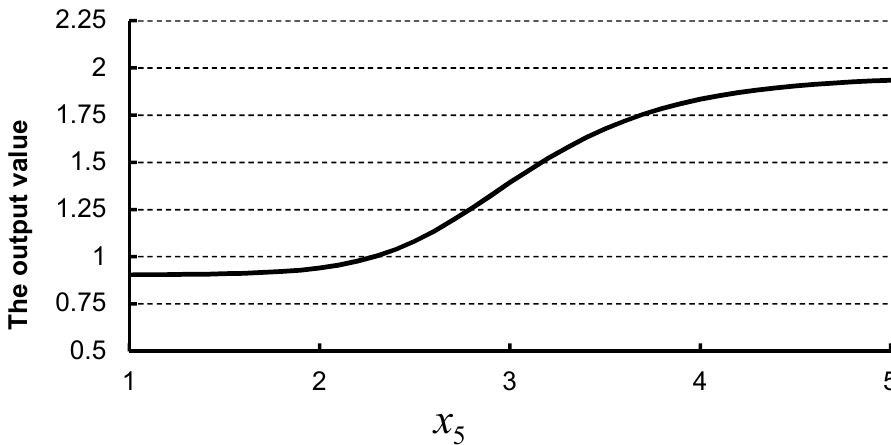
Figure 1. The nonlinear relationship between the score (obtained through surveys or experts, and in the range [1, 5]) of the evaluation indicator x 5 and the output value (risk level) of the established BPNN model.